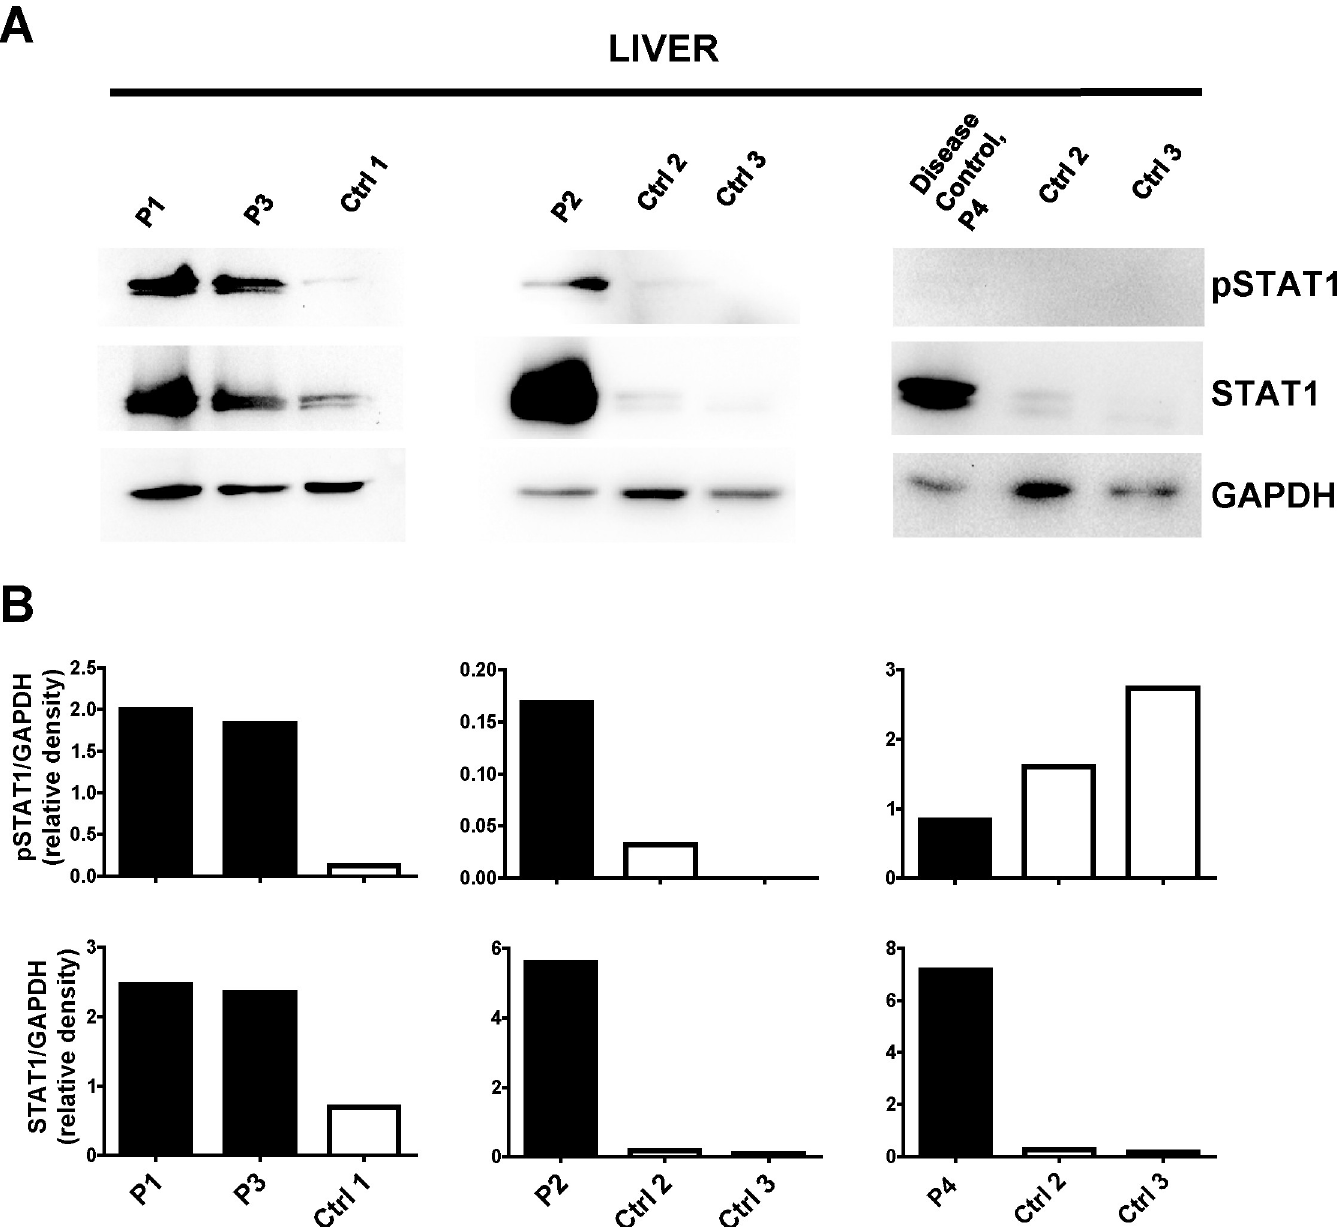
Fig 4. Tyrosine 701-phosphorylated STAT1 and total STAT1 levels are higher in sHLH patient liver biopsies. A) Tyr(701)-phosphorylated STAT1 (pSTAT1) and total STAT1 protein levels were evaluated by Western Blot analyses in patient and control total liver lysates. B) pSTAT1 and STAT1 relative density values were